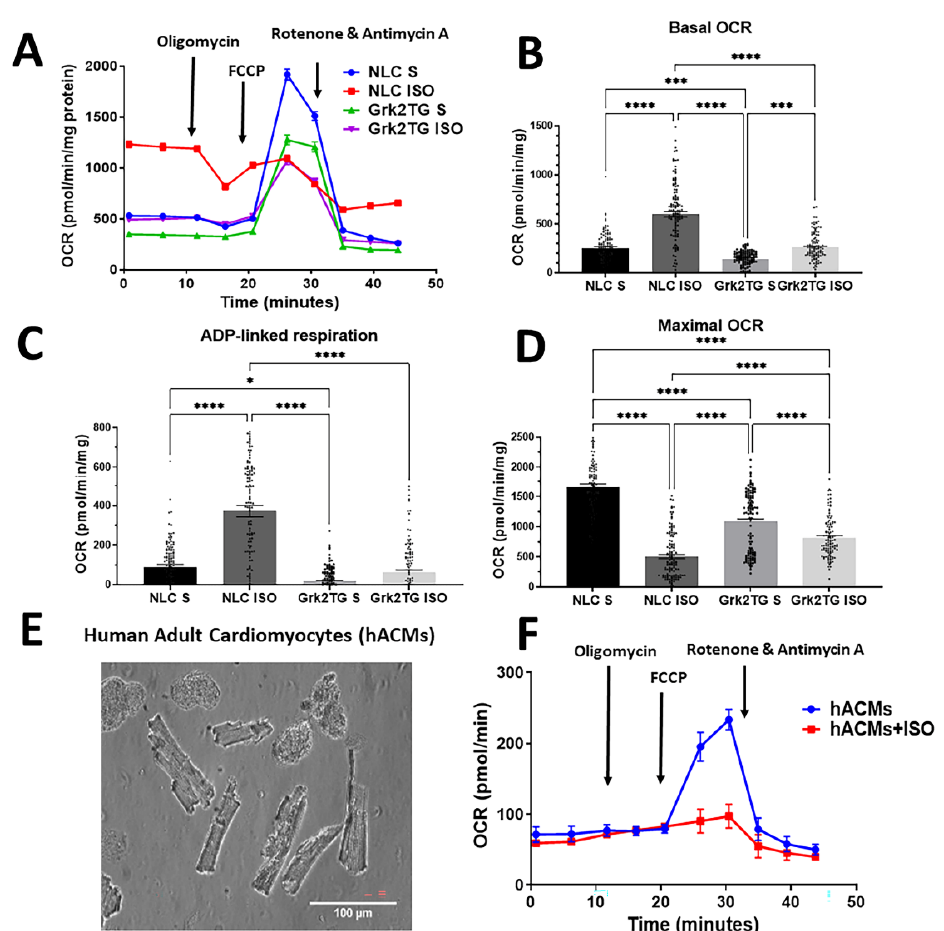
Figure 4. Mitochondrial function responses are altered in response to β AR stimulation and GRK2 expression. ( A ) Overall mitochondrial OCR traces are shown for NLC saline (NLC S; red), NLC ISO (black), Grk2TG + saline (Grk2TG S; blue), and Grk2TG ISO (green) during a mitochondrial stress test ( n = 114 to 144 wells/condition in 3 independent hearts/condition). ( B ) Quantification of basal respiration. ( C ) ADP ‐ linked respiration, and ( D ) maximal respiration are shown from data in panel A (same n value). ( E ) Representative image of hACMs (scale bar is 100 um). ( F ) Mitochondrial OCR in hACMs from the same donor in the presence or absence of ISO, ( n = 20–25 wells/condition) (mean ± SEM, * p < 0.05, *** p < 0.005 and **** p < 0.0001).